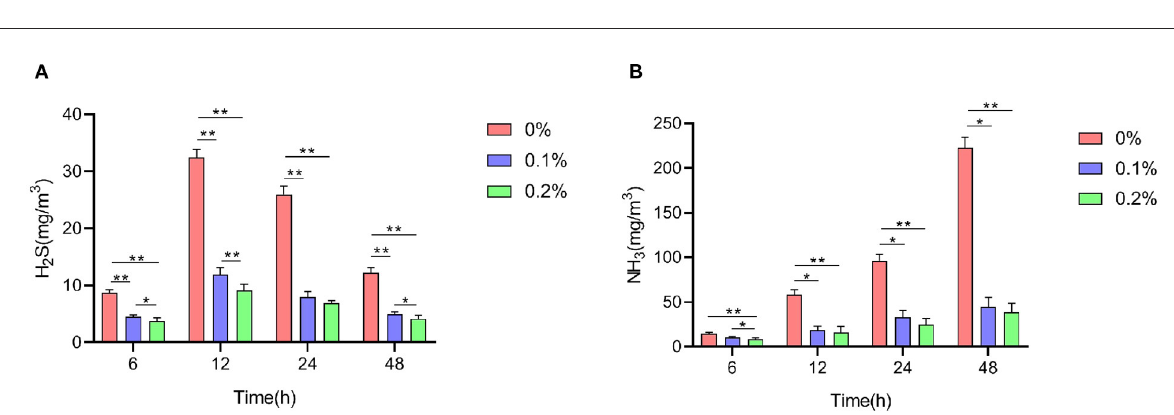
weights of the thymus, bursa and spleen serve as markers of organismal immunity in broilers, and the growth, development and division of immune cells could increase the weight